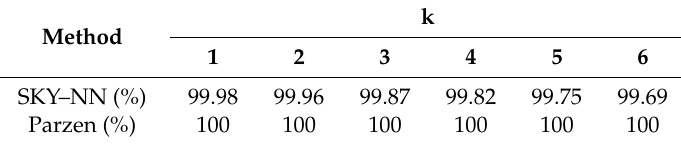
Figure 10. Single skyline on the synthetic Dataset II. Table 12. Single skyline on the synthetic Dataset II.